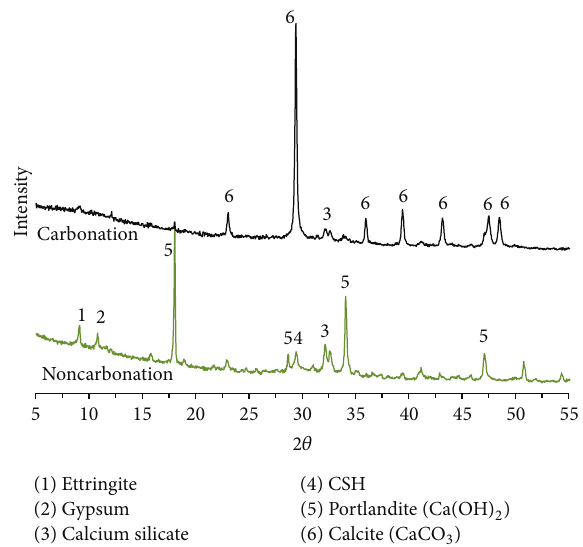
Figure 7: XRD diffraction patterns of carbonated and noncarbon- ated OPC